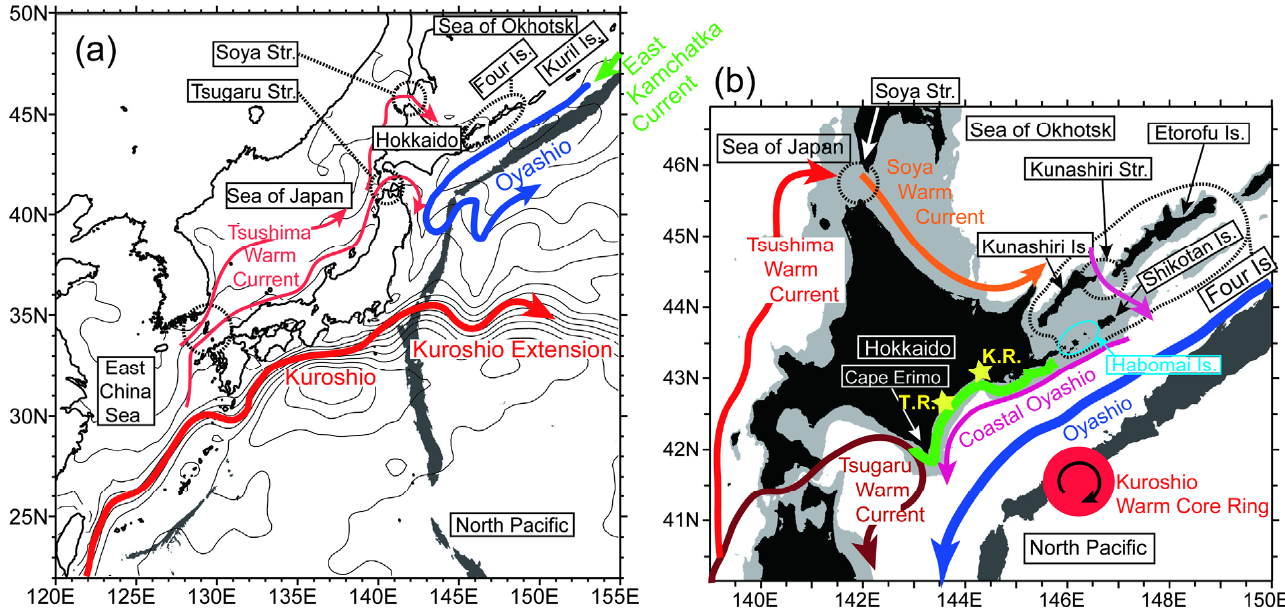
Figure 1. ( a ) Schematic view of surface ocean currents (arrows) around Japan. Geographic names are enclosed in rectan- gles. Contour lines (interval, 10 cm) indicate the 20-year mean absolute dynamic topography during 1993–2012. Water depths ≥ 6500 m (i.e., trenches) are shown by dark grey shading. ( b ) Same as panel ( a ), but for the area around Hokkaido during summer and autumn. Continental shelves where the water depth is <200 m are shown by light grey shading. The yellow stars represent the location of the mouth of the Tokachi River (T.R.) and Kushiro River (K.R.). The green bold line roughly indicates coastal waters where serious fisheries damages have been reported in association with harmful algal blooms during September–October 2021. The Four Islands defined in this study consist of Kunashiri, Etorofu, Shikotan, and Habomai islands.